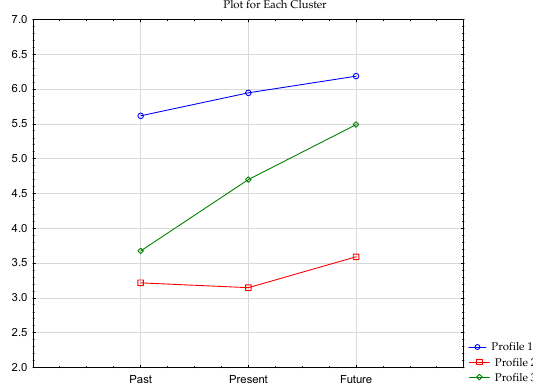
Figure 4. Clusters of TSLQ scale in the sample of respondents.